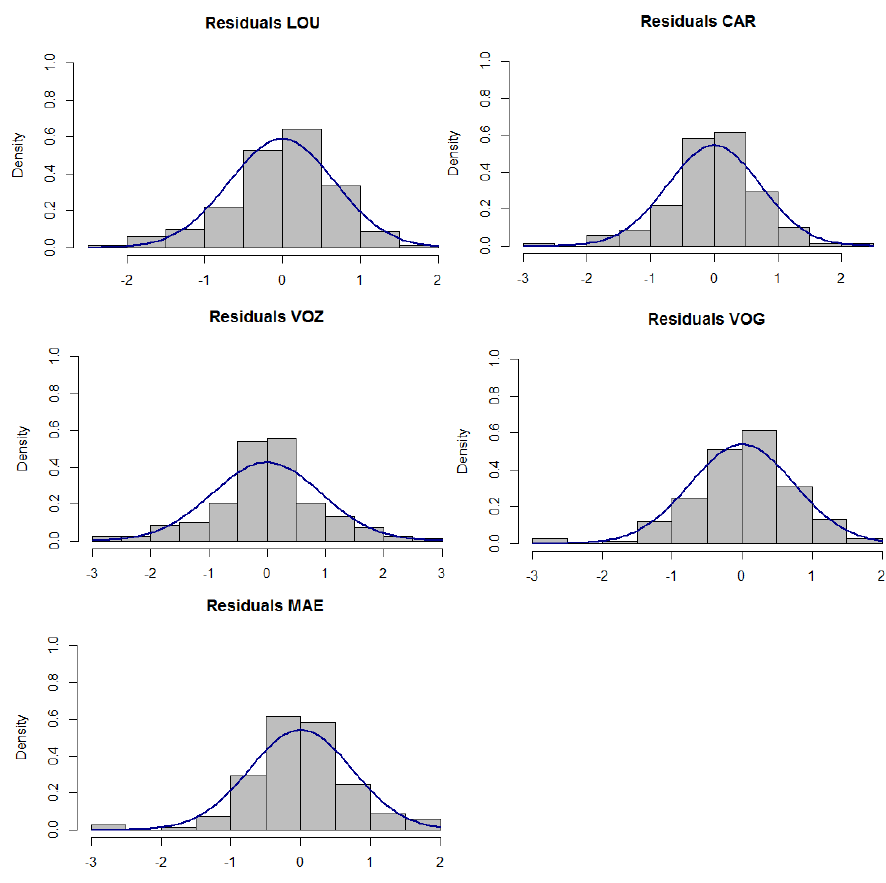
Figure 4. Histograms of residual series for the calibration model (MIII) in each monitoring station, with the adjusted normal curve. Table 4. Results for model MII (2)–(3) for DO concentrations at the different locations. LOU CAR VOZ VOG MAE est. p -val. p -val. * est. p -val. p -val. * est. p -val. p -val. * est. p -val. p -val. * est. p -val. p -val.